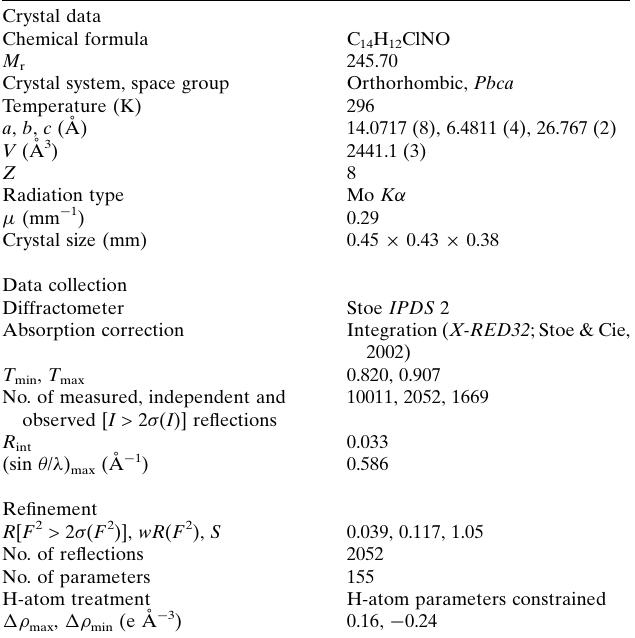
Crystal data Chemical